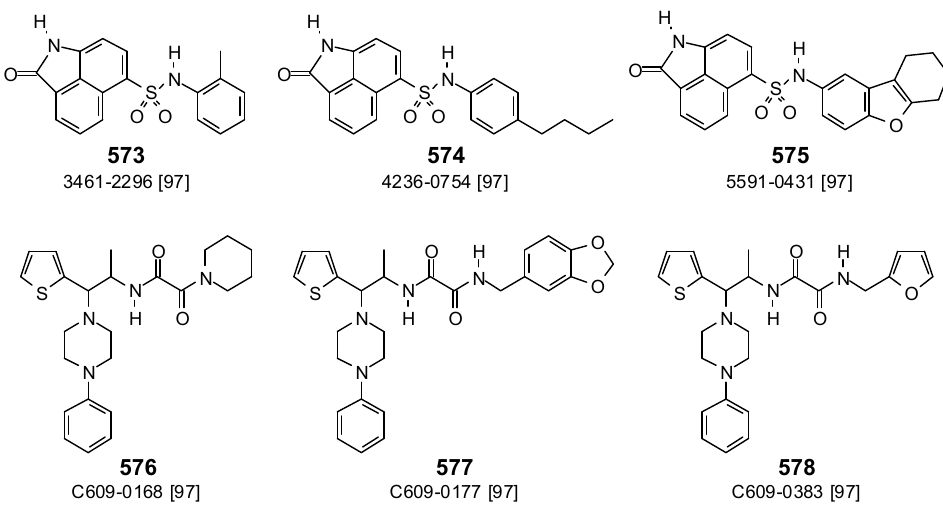
Figure 27. Structures of the synthetic protein tyrosine phosphatase inhibitors.